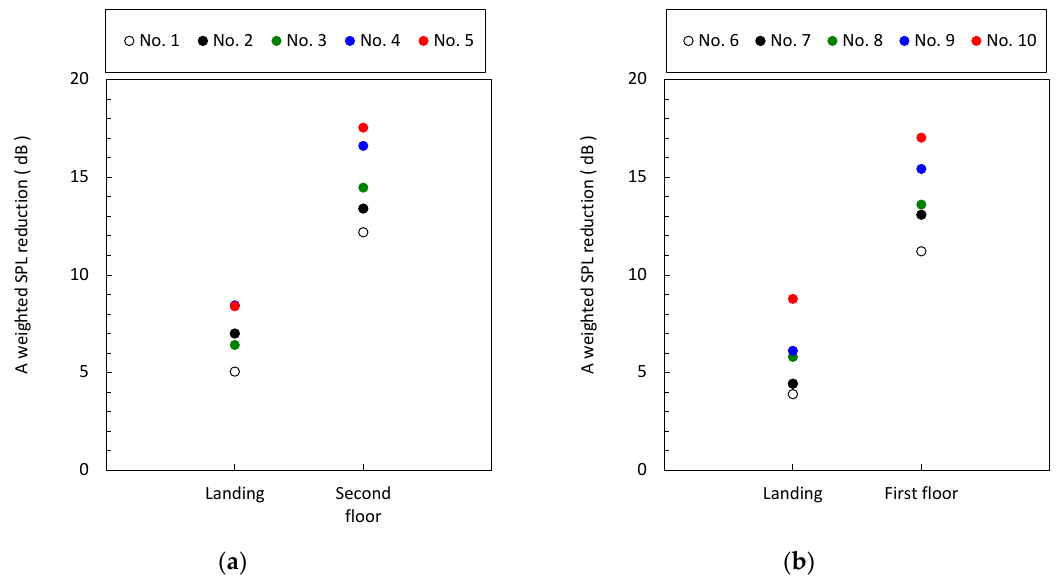
Figure 9. A-weighted SPL reduction at each measurement point. ( a ) Sound source position: first floor; ( b ) Sound source position: second floor.